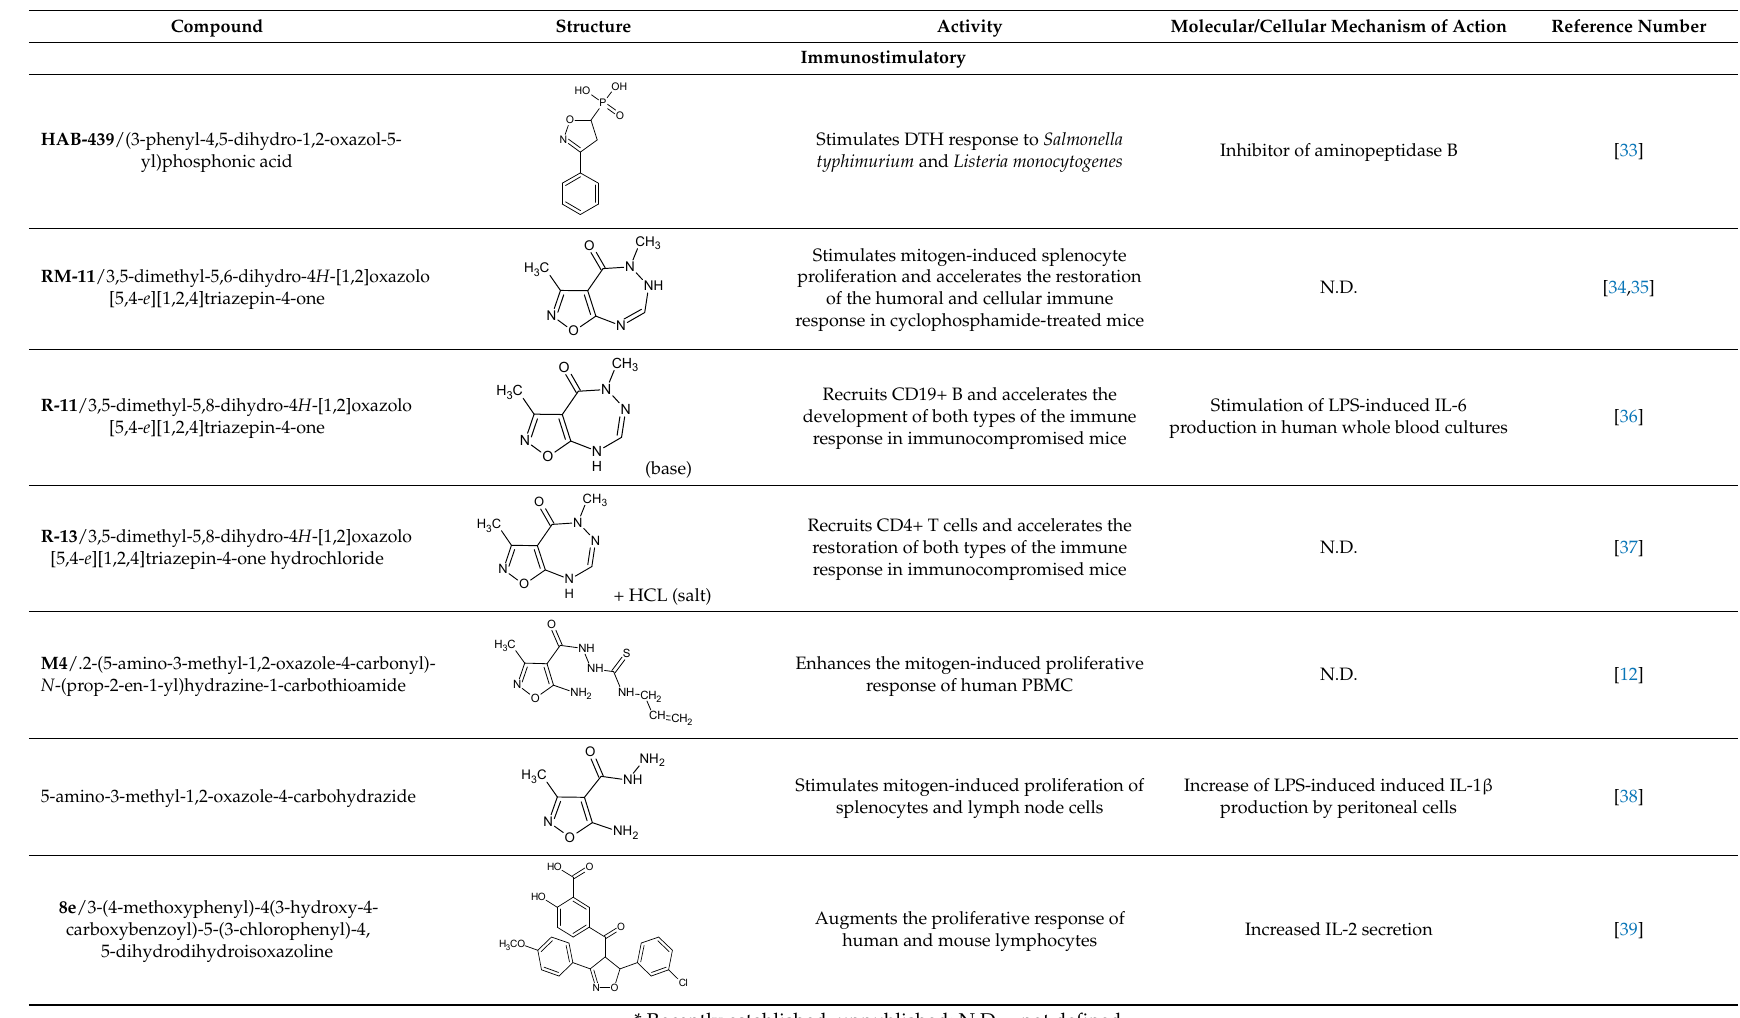
Compound Structure Activity Molecular/Cellular Mechanism of Action Reference Number